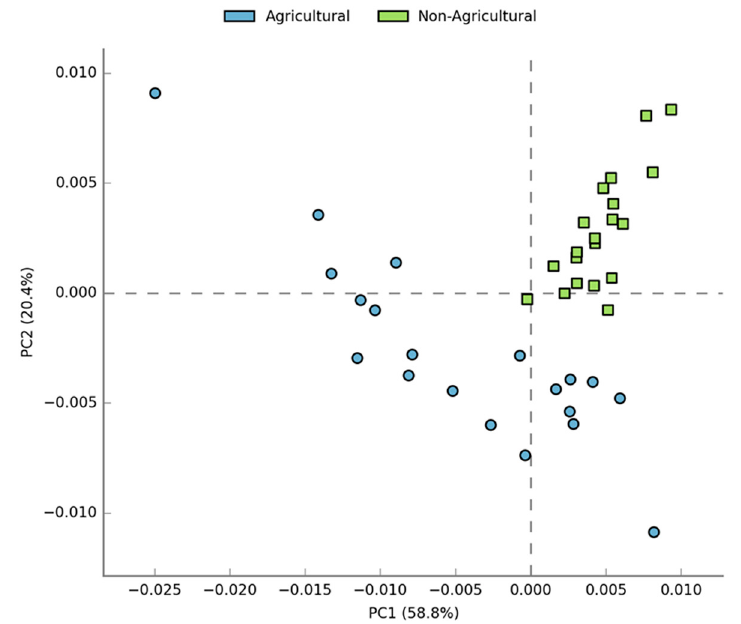
Figure 5. Principal Component Analysis plot of primary features computed using the STAMP software, based on multiple group analysis, applying ANOVA test, Games–Howell post hoc test for confidence interval method and Benjamin–Hochberg FDR for correction. X and Y axes indicate that Principal Components 1 and 2 explain 58.8% and 20.4% of the total variation in the predicted functions, respectively.